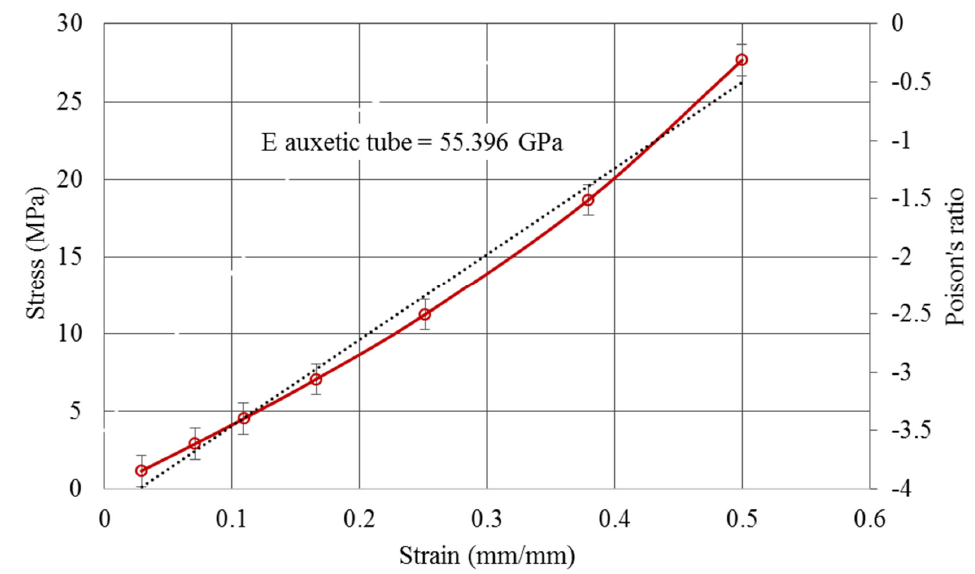
ff ness and Poisson’s ratio for a cellular Figure 10. Average structural stiffness and Poisson’s ratio for a cellular tube. Figure 10. Average structural sti